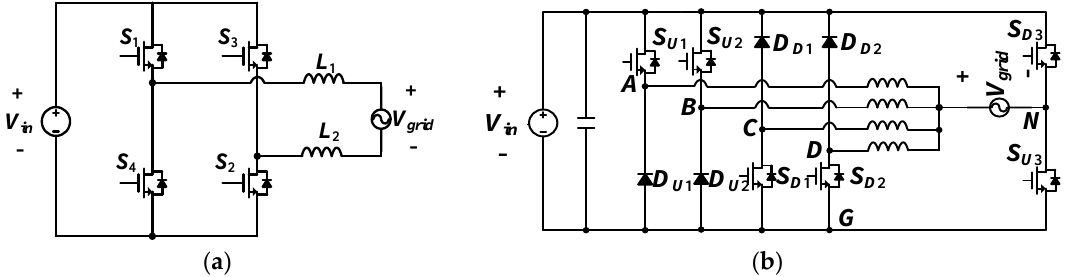
Figure 1. Circuit structure of dc-ac inverters: ( a ) full-bridge inverter (FBI) and ( b ) interleaved dual-buck inverter of [9] (IDBI [9]).